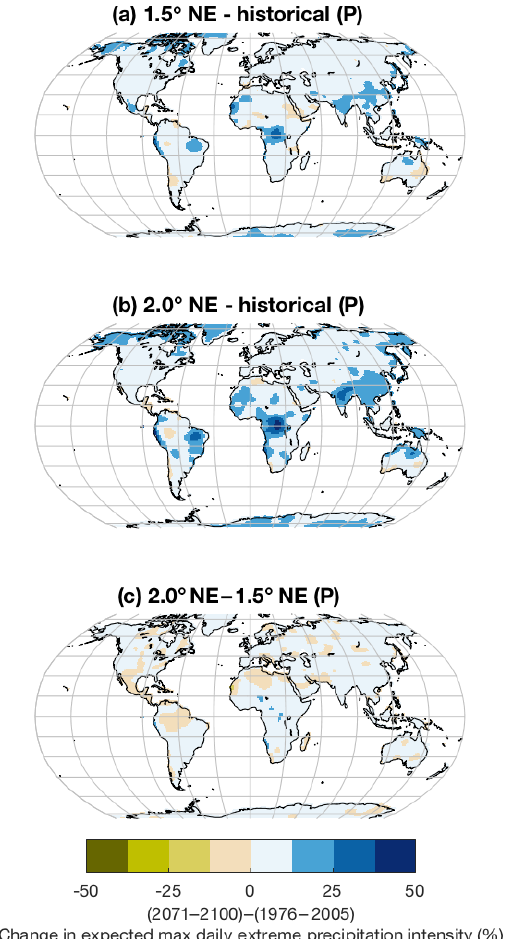
Figure 9. Maps showing the simulated percentage change in en- semble average annual maximum 1-day precipitation for historical periods (1976–2005) and future (2071–2100) for (a) 1.5degNE, (b) 2.0degNE and (c) the difference between the scenarios. Maps are smoothed with a 2-D Gaussian smoothing kernel with SD of two grid